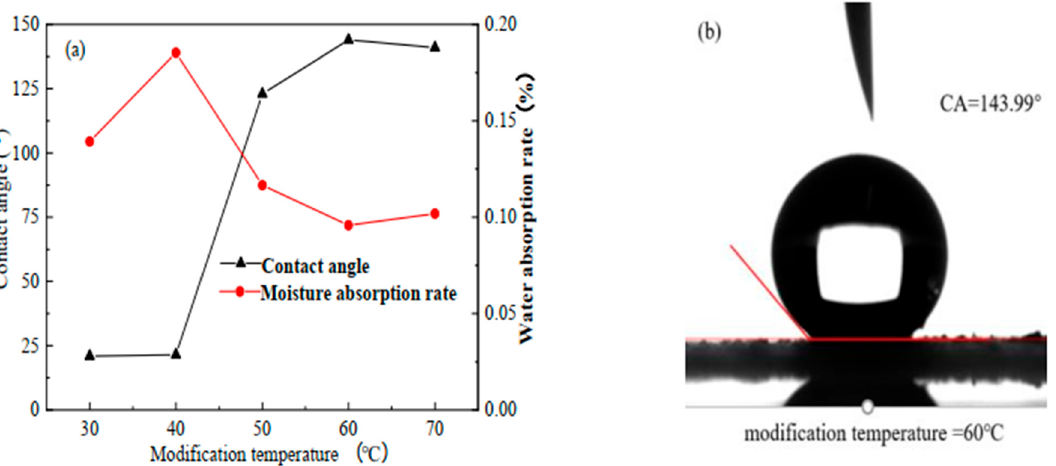
Figure 5. ( a ) Contact angles and moisture absorption rate of modified biochar at different reaction temperatures, and ( b ) contact angle of modified biochar when temperature was 60°C.